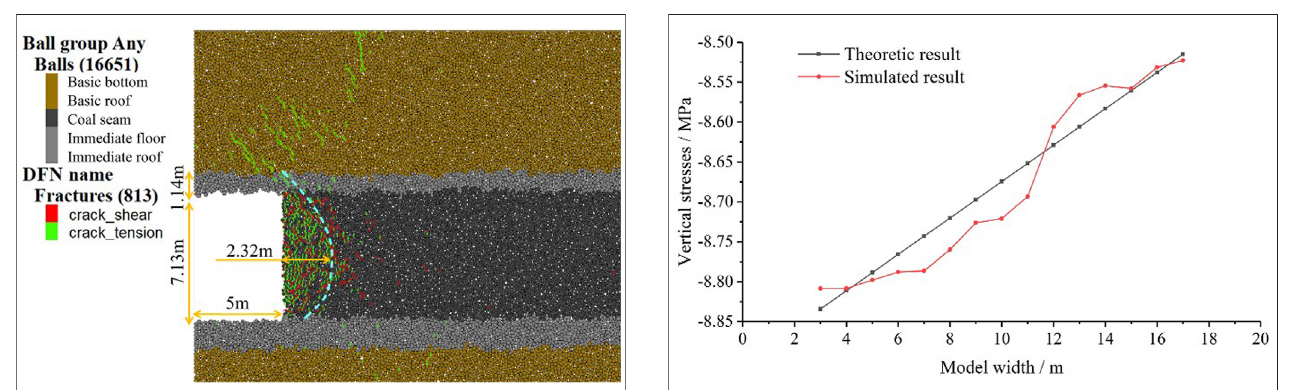
FIGURE 12 | Comparison of debugging stress debugging results of full height mining at one